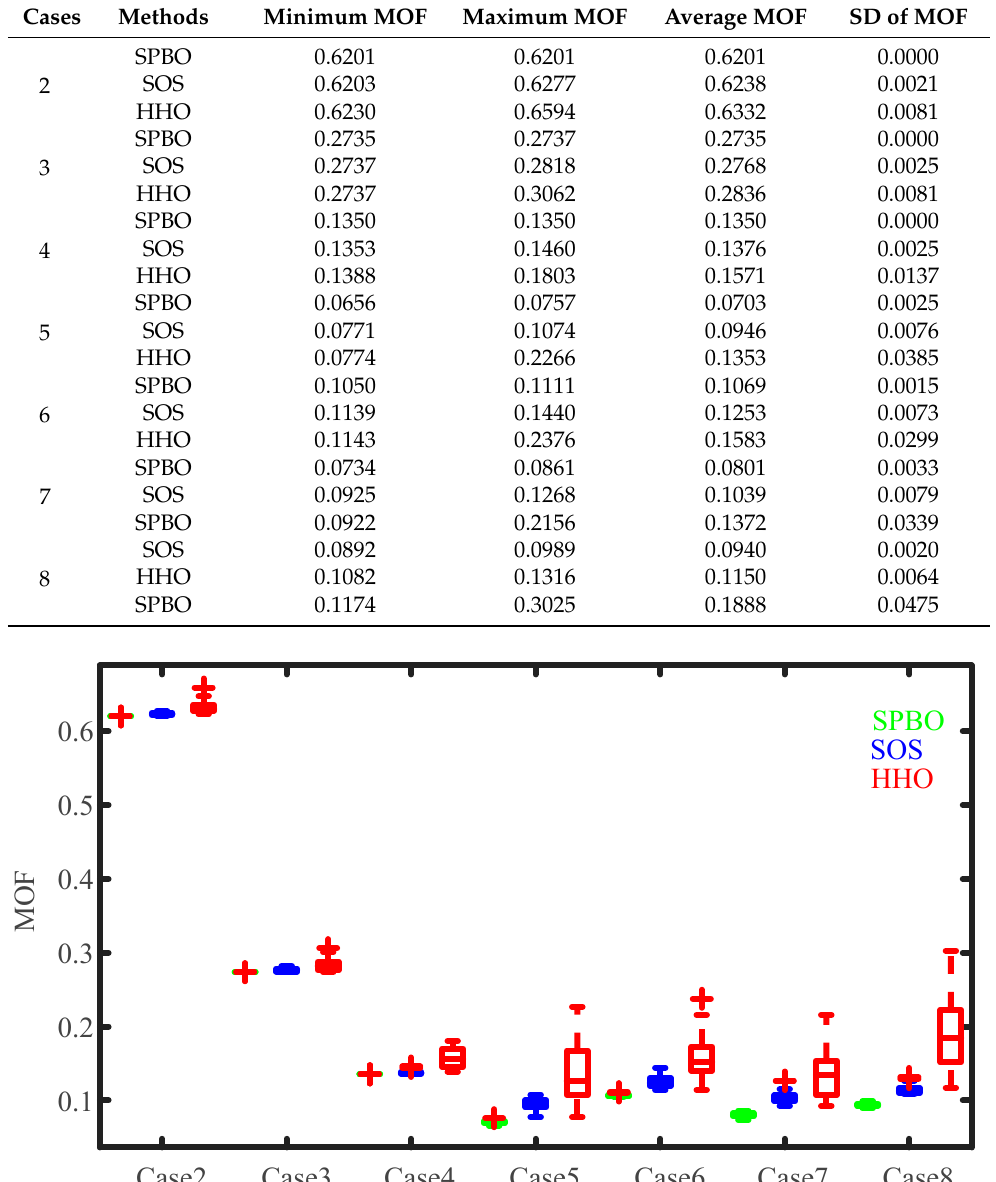
Figure 11. Box plots for 118-node test system. 7. Conclusions A novel MOF has been developed to assess the performance of three parameter-free metaheuristic algorithms (SPBO, SOS, and HHO) for simultaneous allocation of D-STAT- COM and multitype DGs with seven different cases. The MOF included four indices such as RPLMI, BVVMI, SVSMI, and SACMI, accounting for the technological, economic, and environmental benefits of the planning in active distribution networks in the presence of solar PV-DGs, GT-DGs, and D-STATCOMs on two standard test systems (33-bus and 118- bus). The simulation findings clearly indicate that the SPBO method is preferable to the